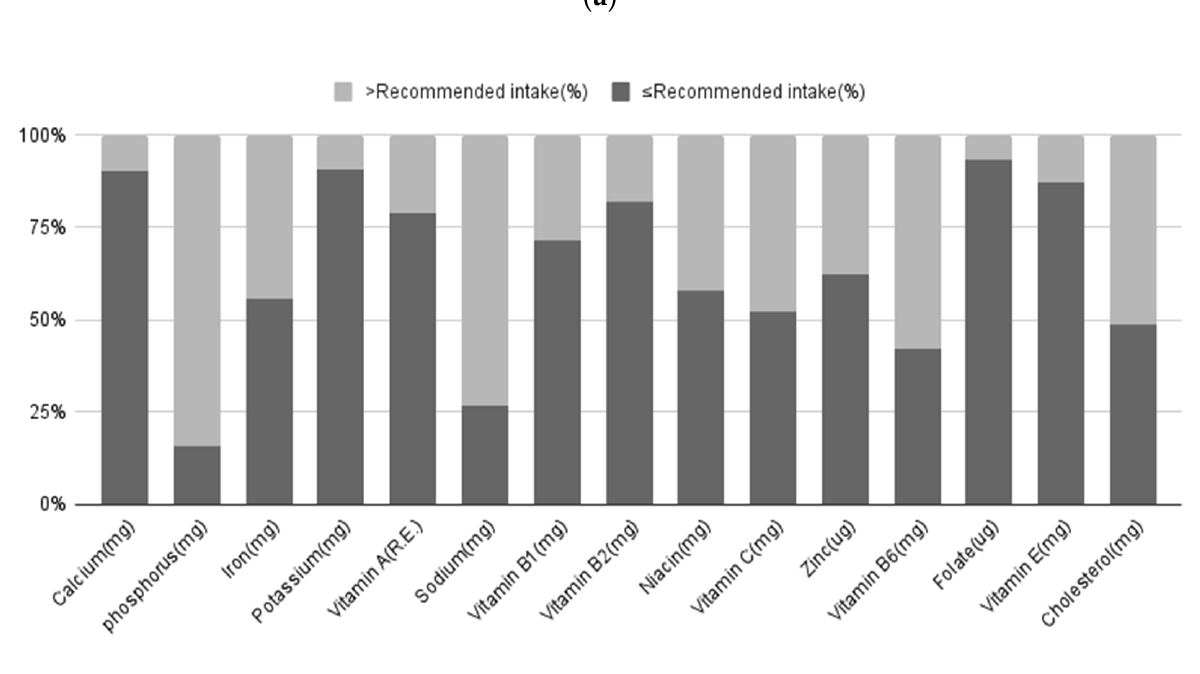
Figure 2. Recommended intake levels of nutrients for breast cancer (%). ( a ) Normal people; ( b ) People with breast cancer.